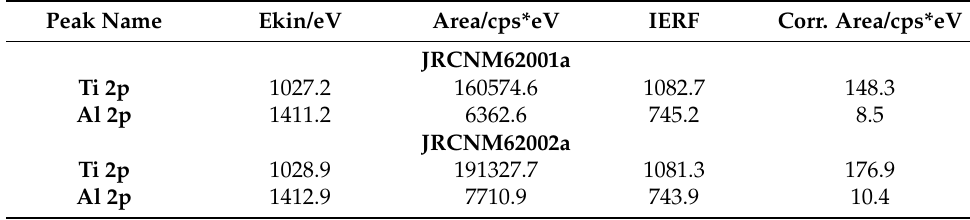
Table A1. Areas of the peaks corrected with the intensity–energy response function (IERF) of the spectrometer. These values were used for the calculation with simulation of electron spectra for surface analysis (SESSA). The estimated uncertainty is up to 10% with a confidence level of